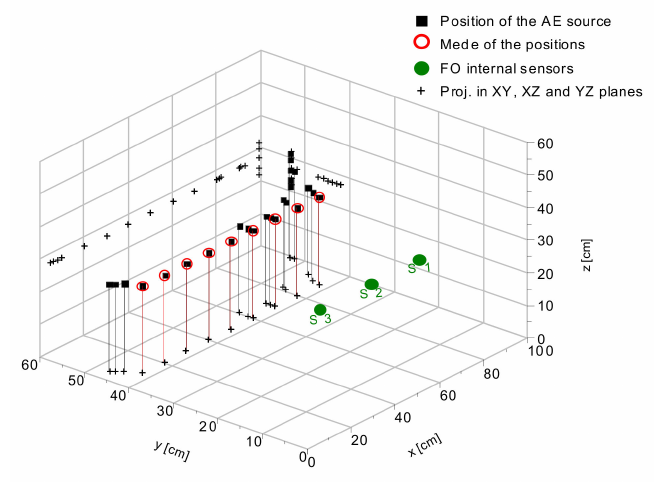
Figure 15. AE source location for a sweep in X axis.